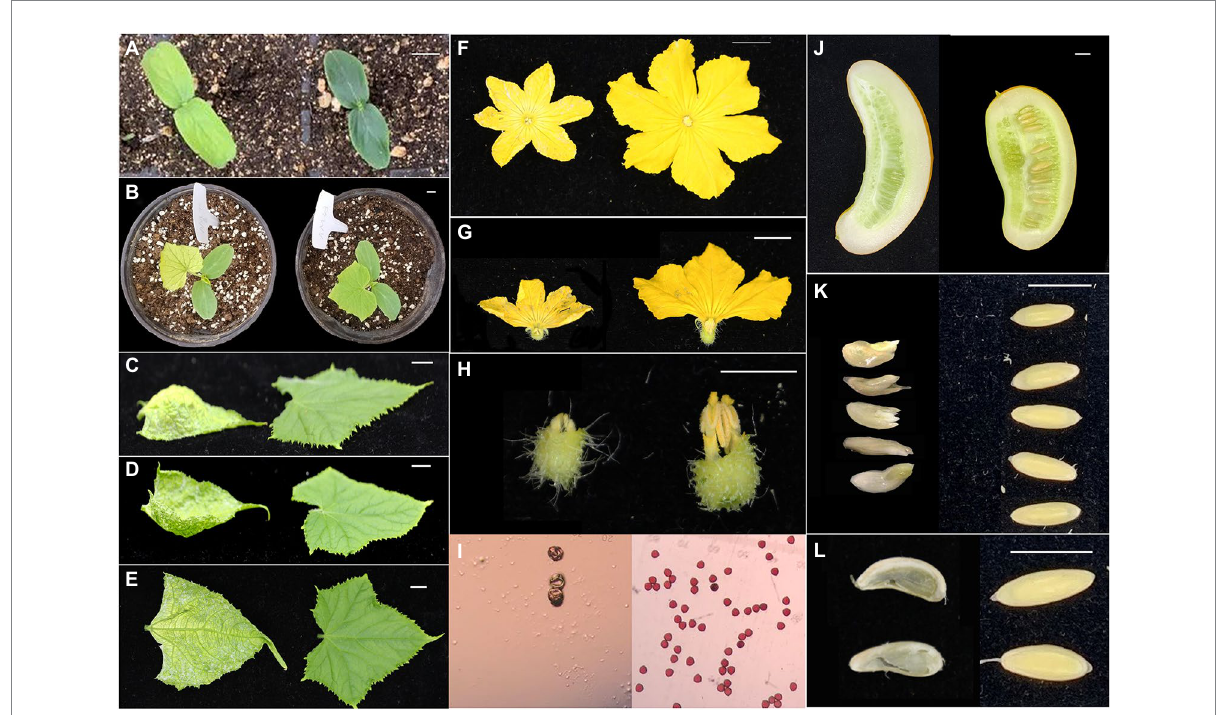
FIGURE 1 Phenotypic analysis of the v-3 mutant. (A) Cotyledon color of v-3 and the WT. (B) True leaf color of v-3 and the WT. (C) Upward convex leaf of v-3 and normal leaf of the WT. (D) Downward concave leaf of v-3 and normal leaf of the WT. (E) White hyaline cracks of v-3 and normal leaf of the WT. (F) Male flower of v-3 and the WT. (G) Male flower section of v-3 and the WT. (H) Stamen of v-3 and the WT. (I) Pollen of v-3 and the WT. (J) Section of fruit after selfing of v-3 and the WT. (K) Seeds after hybridization of v-3 and the WT. (L) Testa after hybridization of v-3 and the WT. Scale bar = 1 cm. WT, wild